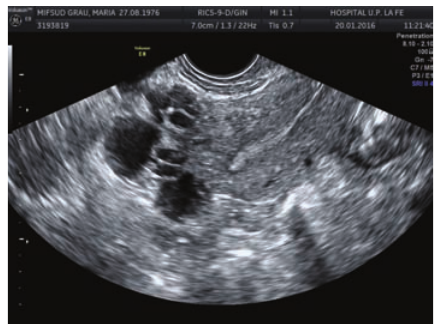
Figure 3: Transvaginal ultrasound image of the cystic endosalpin- giosis lesions 3 months after the cesarean section. The fundus and part of the uterine body were still covered with multitude of cyst-like structures resembling hydatids of Morgagni. The endosalpingiosis lesions did not disappear after